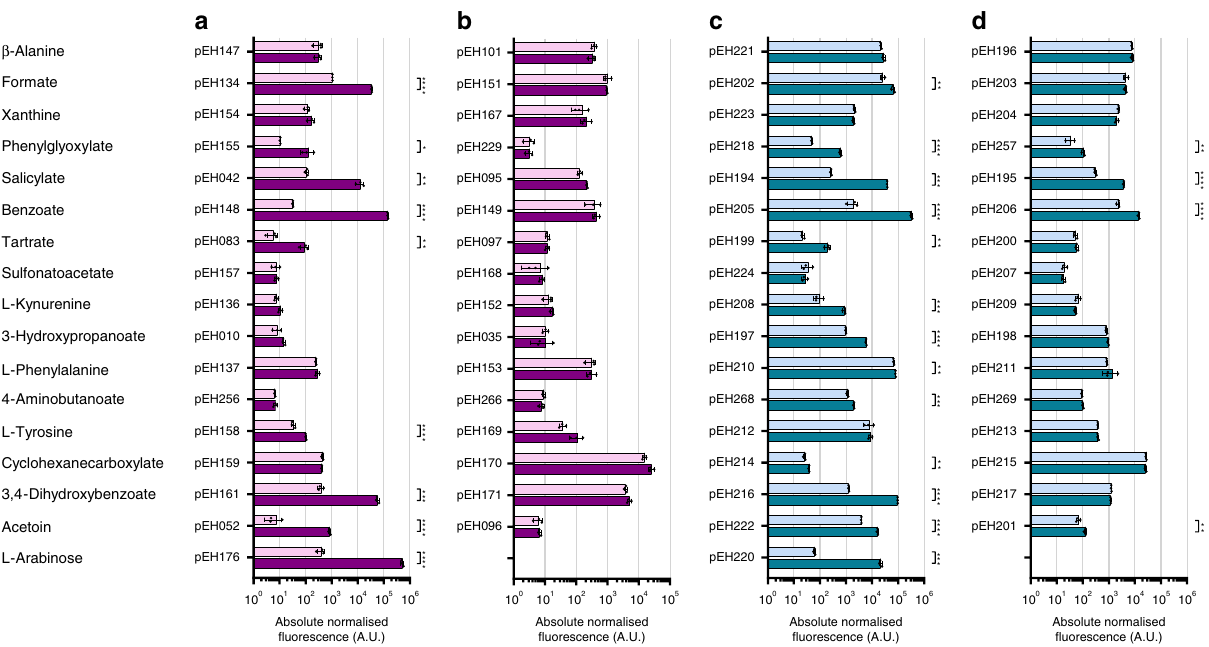
Fig. 3 C. necator native systems mediate controllable gene expression in E. coli and P. putida . Single time-point fl uorescence measurements of a , b E. coli and c , d P. putida carrying the C. necator- inducible gene expression systems composed of TR and promoter a , c or ‘ promoter only ’ version b , d . The plasmids harbouring the individual system – or promoter – reporter gene constructs are indicated. RFP fl uorescence output was determined in the absence of inducer (light purple and light blue) and 6 h after extracellular supplementation with the corresponding primary effector to a fi nal concentration of 5 mM (dark purple and dark blue). Data are mean ± SD, n = 3, * p < 0.05, ** p < 0.01, *** p ≤ 0.001, **** p ≤ 0.0001, unpaired two-tailed t -test. Source data are provided as a Source Data fi le.